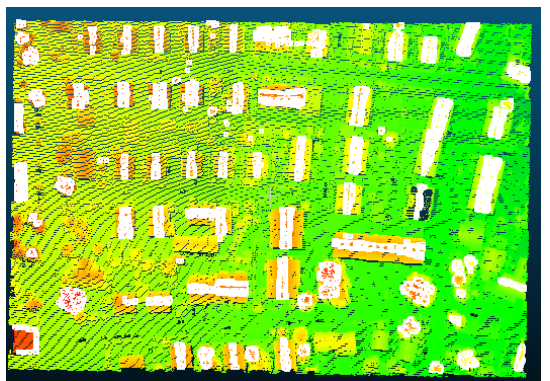
Figure 4.The non-ground seed points in the measured area extracted by the CSF